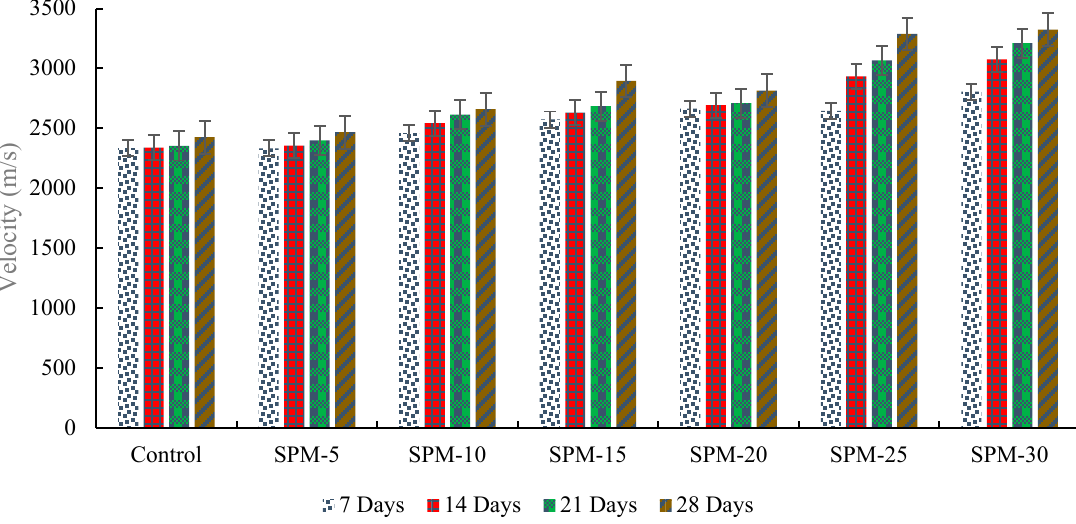
Figure 6. Ultrasonic pulse velocity results of mortars at different treatment conditions with SPs.